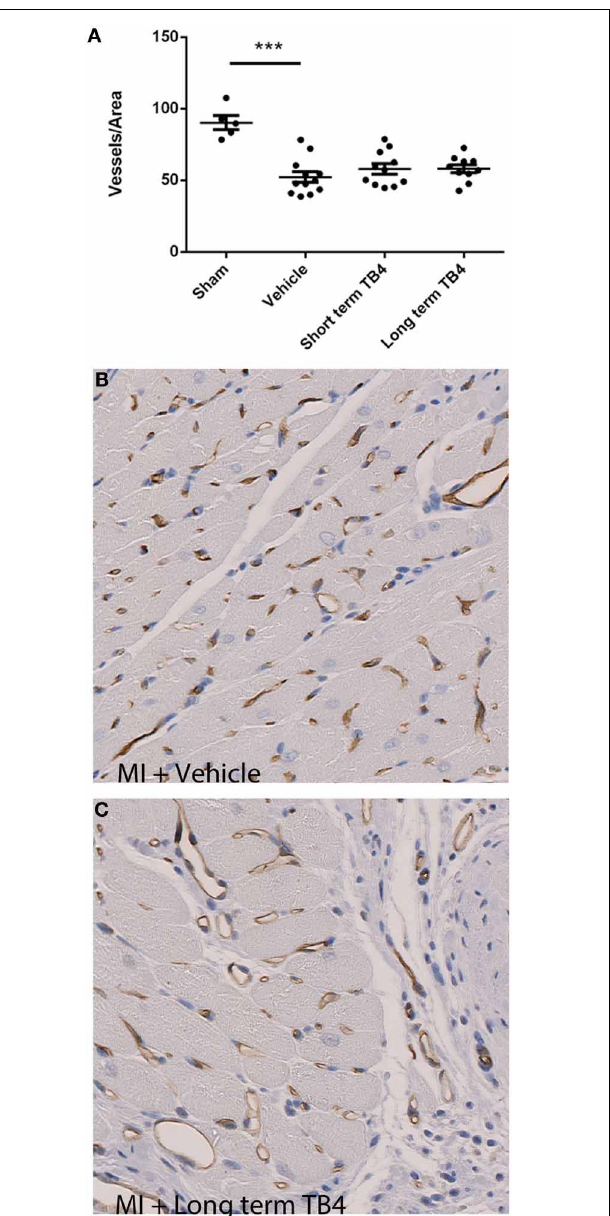
FIGURE 5 | Quantification of blood vessel density in regions near the infarcts in animals receiving coronary artery ligations. (A) T β 4 treated groups did not display a significant increase in blood vessel density per unit area. ∗∗∗ P < 0 . 001 sham operated vs. MI + Vehicle (B,C) Representative histological stains for blood vessels from treatment and control sections; brown staining indicates RECApositive